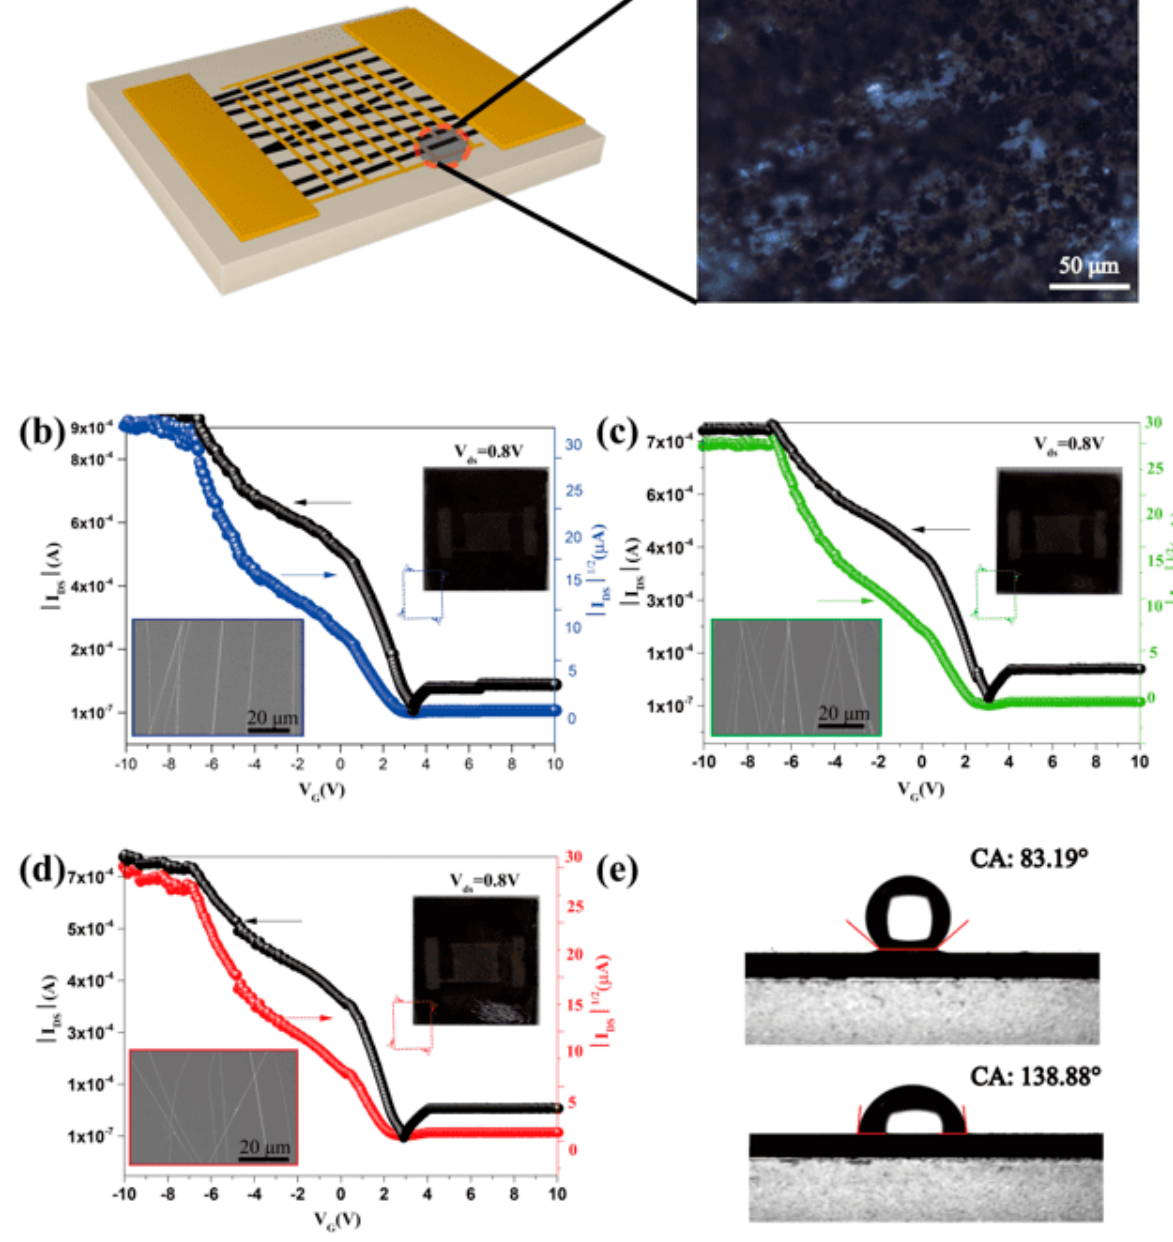
Figure 5. ( a ) Schematic diagram of a top-contact Cu 3 (HITP) 2 NFAs-based FET device (left), and op- tical microscopy image of Cu 3 (HITP) 2 NFAs deposited over a (n ++ ) Si substrate. ( b – d ) Transfer characteristic for FET devices using Cu 3 (HITP) 2 NFAs /(n ++ ) Si spun at ( b ) 500 r/min, ( c ) 400 r/min, and ( d ) 300 r/min (Illustration: FETs devices diagram in upper right, SEM of Cu 3 (HITP) 2 NFAs in lower left). ( e ) Contact angle of water on Cu 3 (HITP) 2 NFAs of (n ++ ) Si substrate(above), and (n ++ ) Si substrate (below).